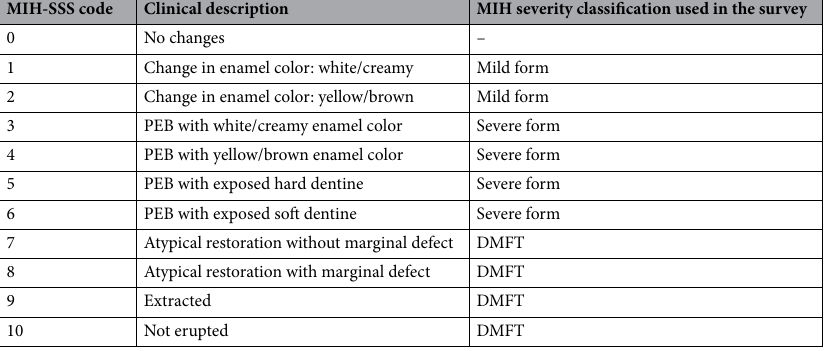
Table 6. MIH classification used in the survey based on MIH-SSS